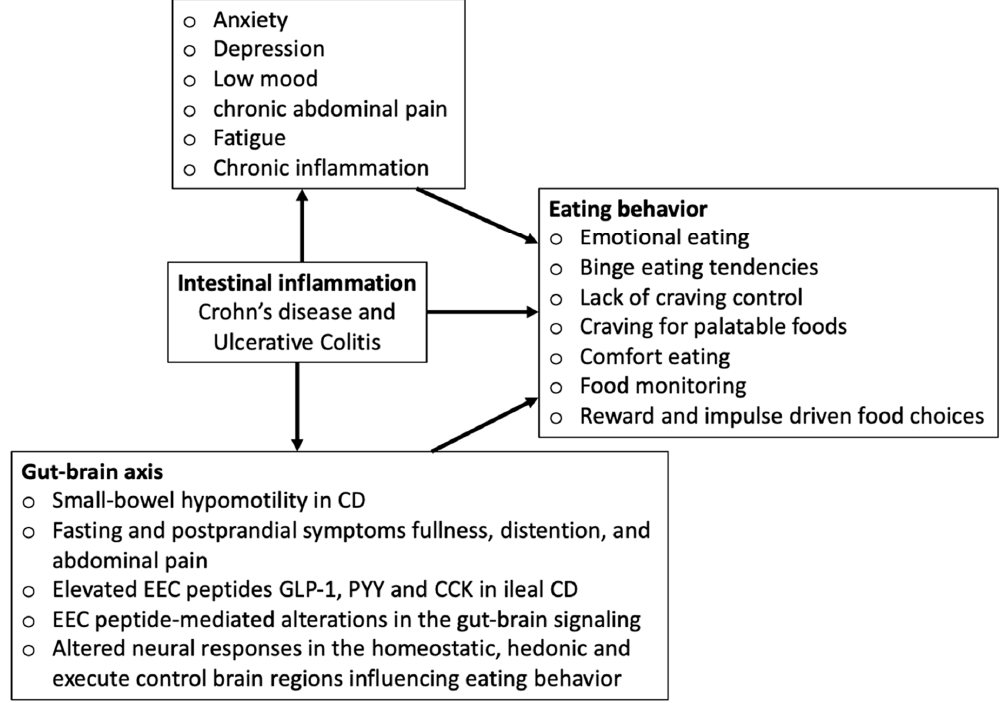
Figure 1. Conceptual framework .